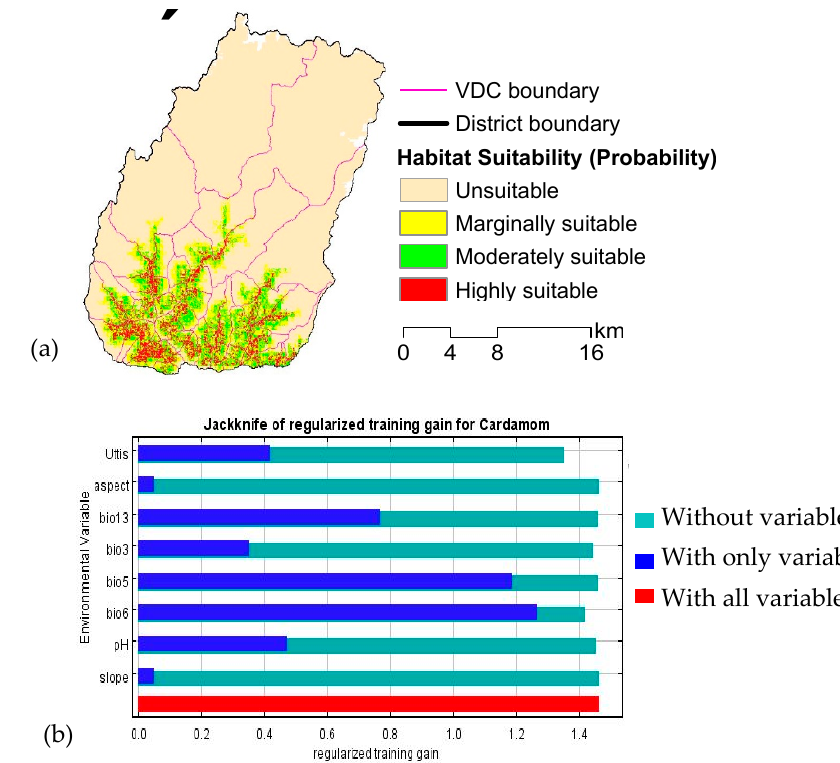
Figure 6. ( a ) Potential distribution of cardamom in the district, ( b ) Relative predictive power of different contributing variables based on the jackknife of regularized training gain in the Maxent model for large cardamom.